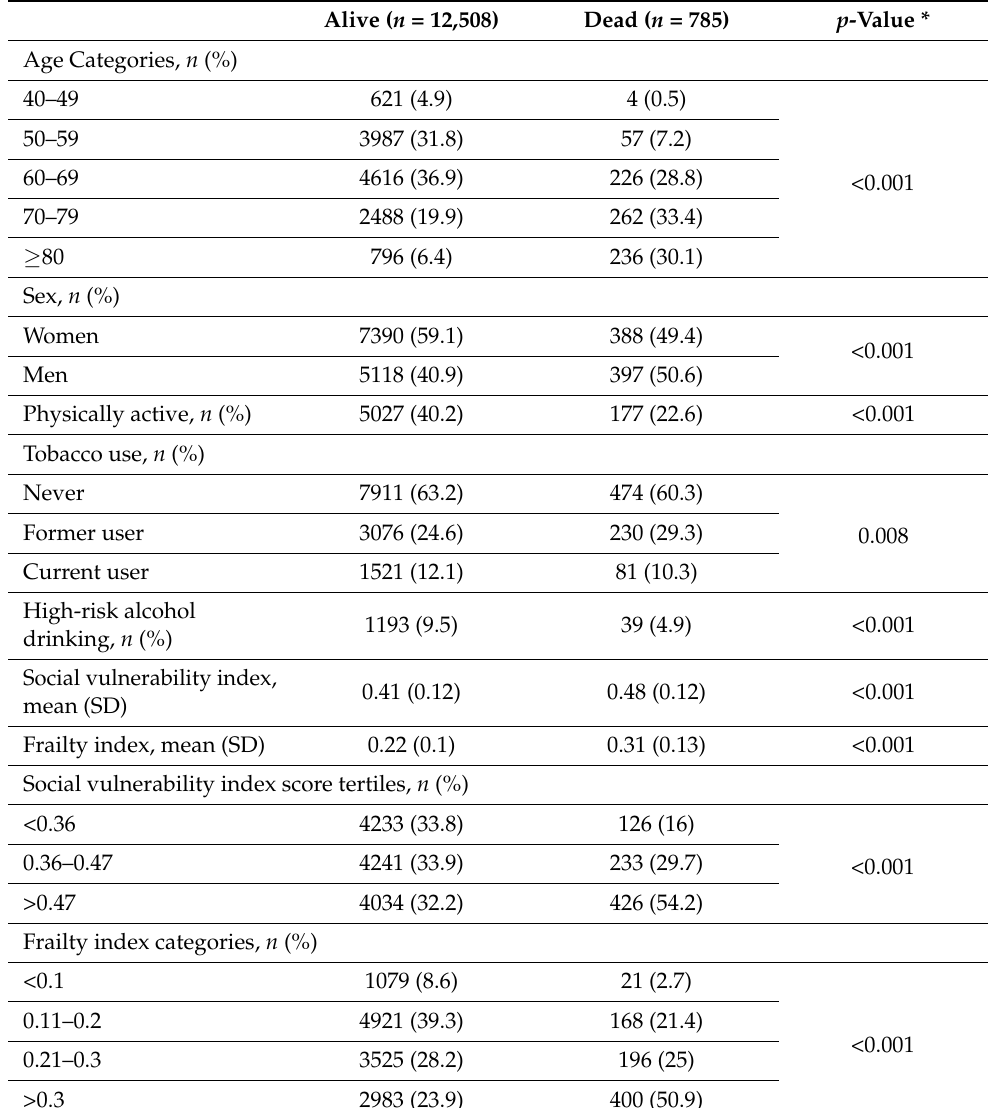
Table 2. Bivariate analysis of